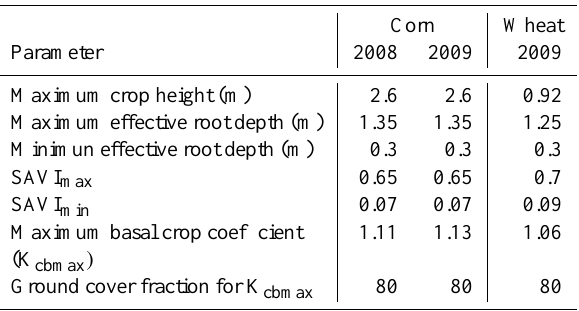
Table 1. Crop parameter values used for deriving the crop coef- ficients and computing the water balance following the procedure described in FAO Irrigation and Drainage Paper No. 56 (Allen et al.,